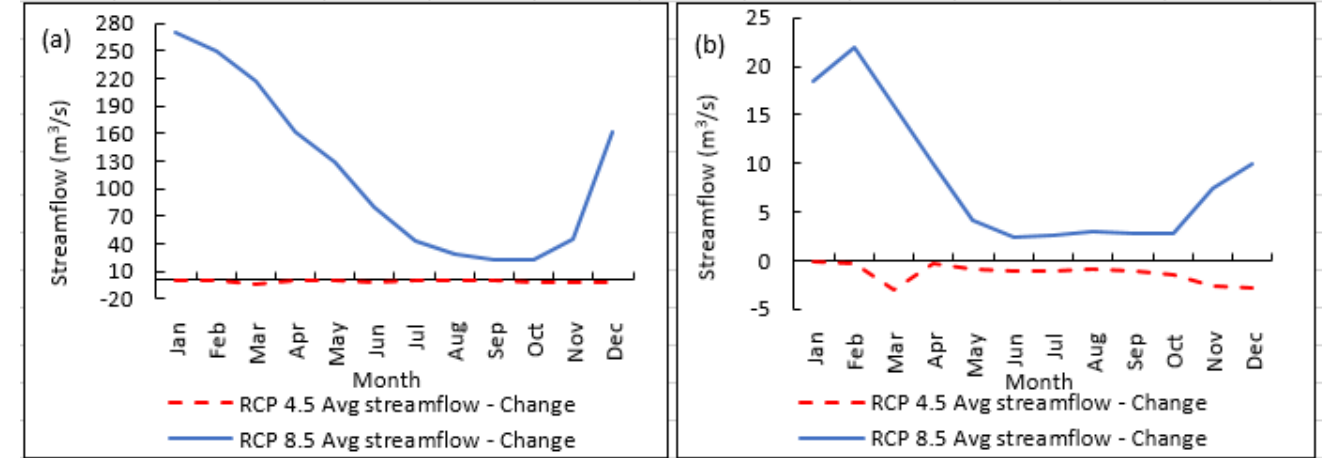
Figure 6. Ensemble mean streamflow changes ( a ) under high uncertainty; and ( b ) strong consensus.